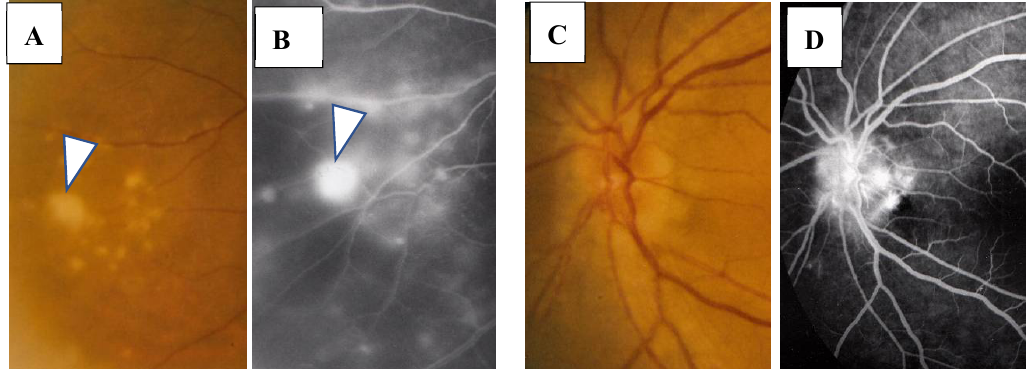
Figure 5. ( A – D ) Images of the right eye of Case 32, a 55-year-old female in Group II with a max IOP of 18 mmHg. Photographs of the fundus ( A , C ) and FFA ( B , D ). Nodule (arrowhead in A ) shows almost the same size of fluorescein leakage (arrowhead in B ). Nodules in the optic nerve head ( C ) show a granular staining pattern of fluorescein leakage ( D ).